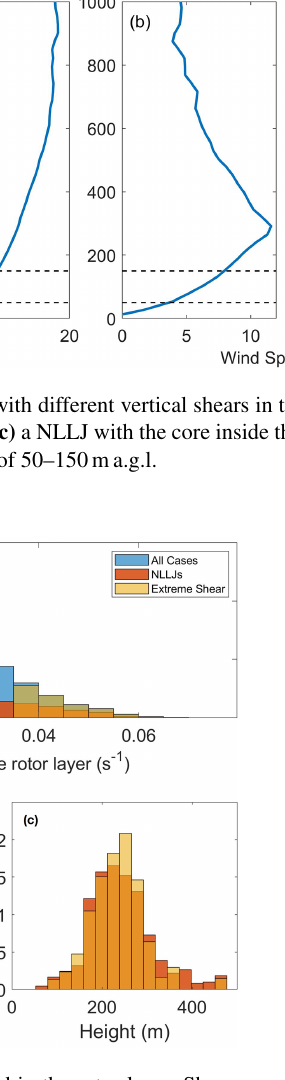
Figure 17. Vertical shear of wind speed in the rotor layer. Shown are (a) the number of occurrences of vertical shear in the rotor layer and the frequency of (b) wind speed and (c) height. All conditions are shown in blue, NLLJs in red and extreme shear cases in yellow. Extreme shear was defined by the 90% percentile (0.0354s − 1 ).